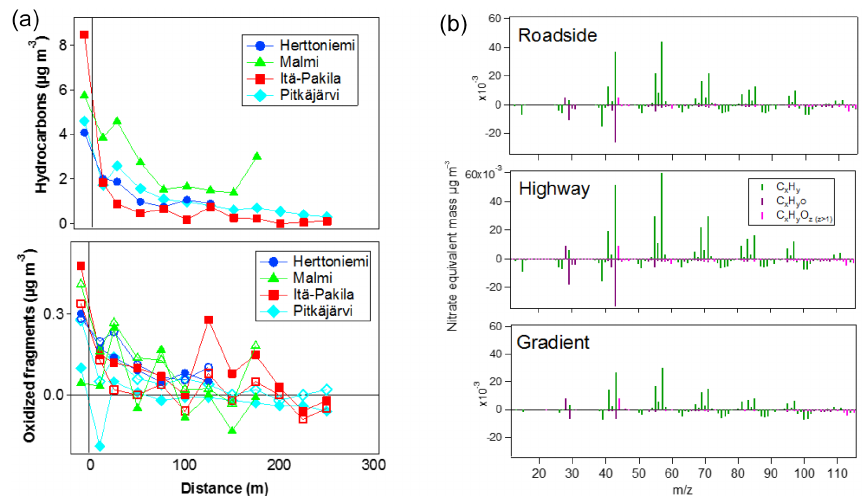
) and oxidized organic fragments (C X H Y O + and C X H Y O + ) measured at Figure 6. Concentrations of hydrocarbon fragments (C X H + Y Z,Z> 1 the four sites (a) , and the average mass spectra for highway, roadside, and gradient at Pitkäjärvi (b) . Solid markers refer to organic fragments with one oxygen atom and open markers to organic fragments with more than one oxygen atoms in lower figure of (a) . In (a) zero distance refers to the roadside and negative value driving on the highway. Background values were subtracted both from the measured concentrations and mass